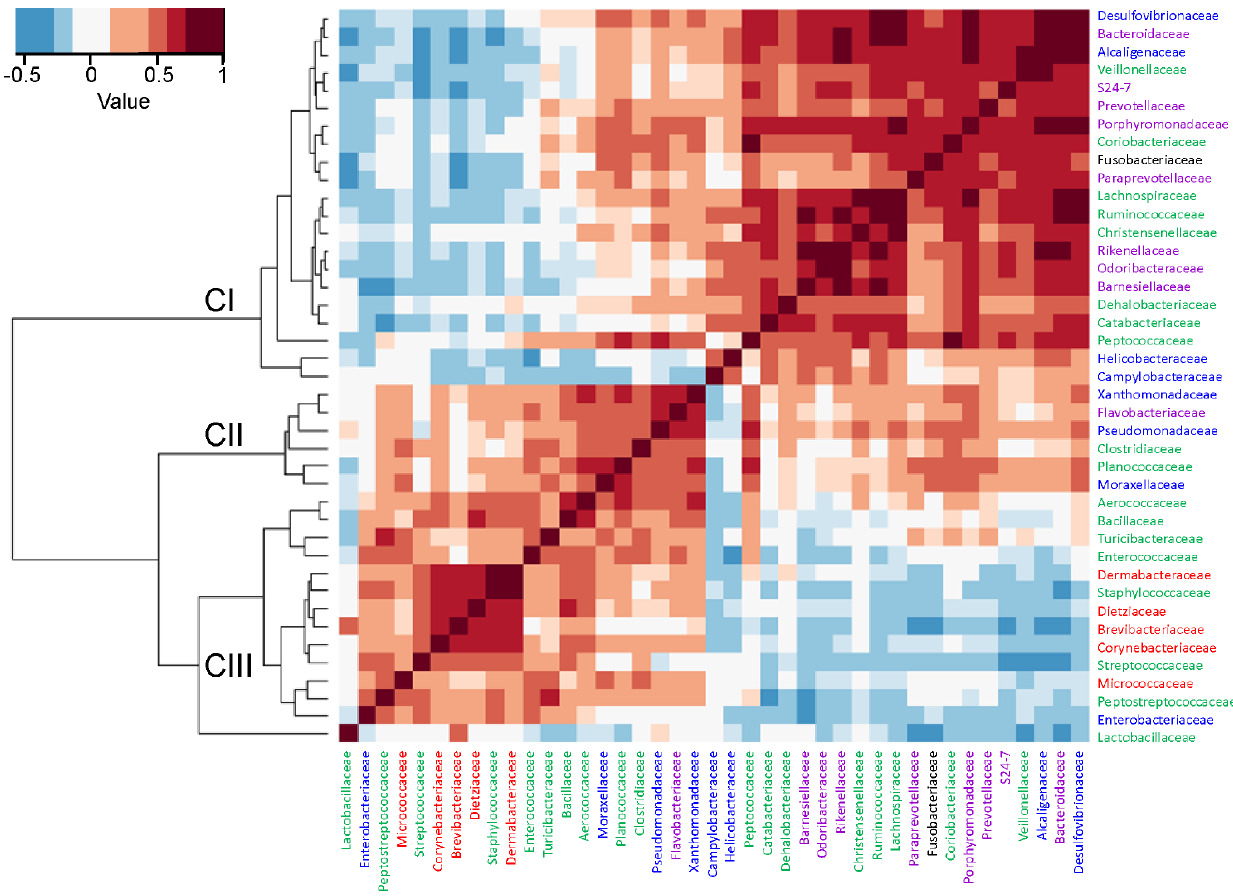
Figure 3. Identification of core chicken fecal microbiota. Cluster I (CI) of positively correlating bacterial families represents families common to established chicken fecal microbiota of adult hens. Interestingly, representatives of Helicobacteraceae and Campylobacteraceae were clustered with these families, although as the most distant members. Cluster II (CII) was formed mainly by the families which are characteristic of aquatic environments. Cluster III (CIII) of positively correlating bacterial families included bacterial families that were mainly characteristic of gut microbiota of young broilers. Families in green belong to the phylum Firmicutes , purple to Bacteroidetes , blue to Proteobacteria and red to Actinobacteria . Shades of brown – positively correlating families; shades of blue – negatively correlating families.